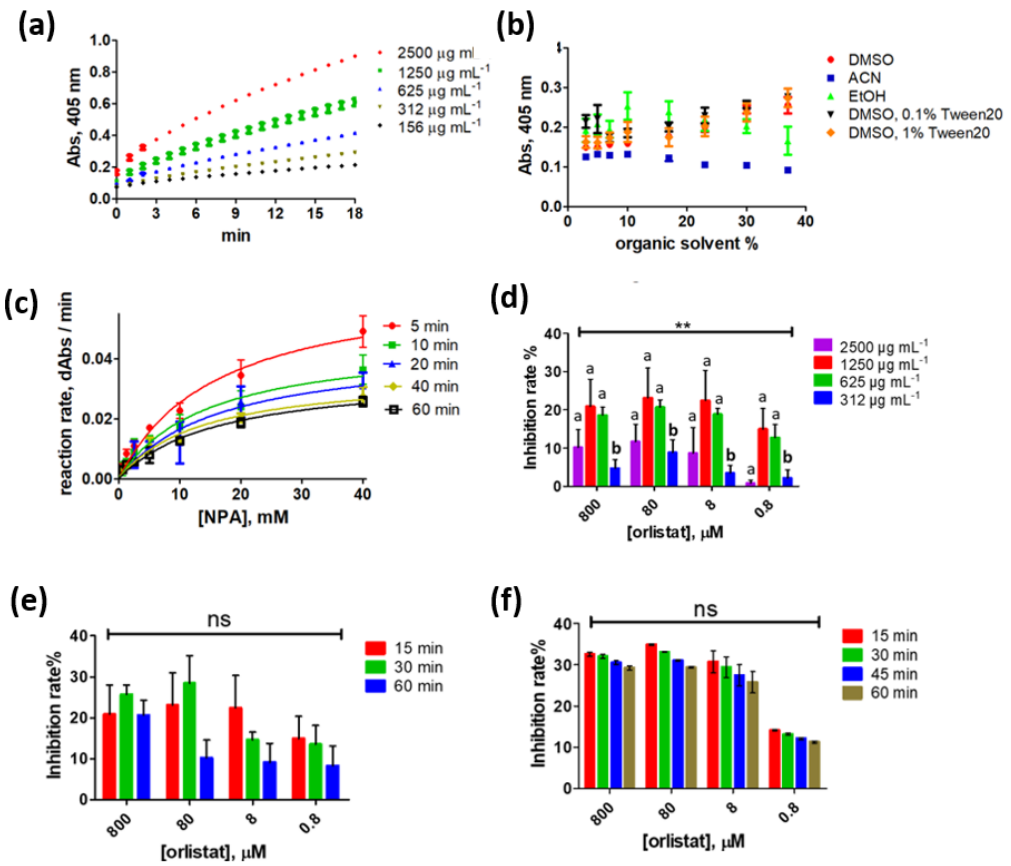
Figure 2. The investigated assay parameters: ( a ) monitored absorbance at 405 nm vs. time (min), n = 4 replicates per level, ( b ) Michaelis–Menten kinetics calculated at 5 different time intervals, n = 6